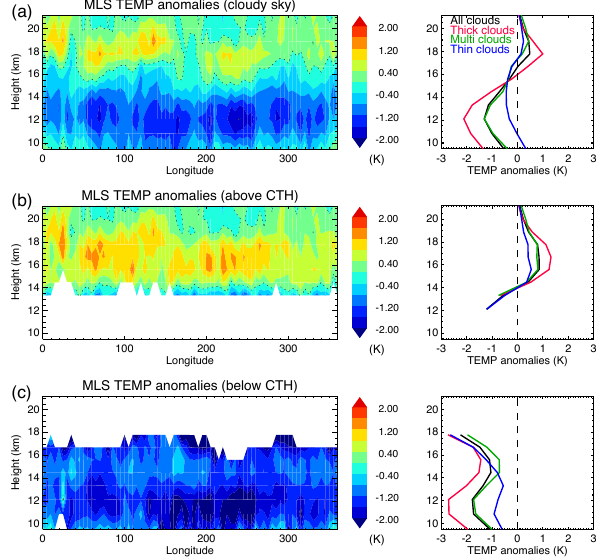
Fig. 3. Time mean vertical profiles of temperature anomaly from the local, clear-sky mean temperature for cloud tops above 10 km (a). (b) the same as (a) except that only data at least 1.5 km higher than the cloud top height (CTH) are included in the average. (c) the same as (a) except data height is below cloud top but not by more than 3 km. Right figures show zonally averaged anomalies of absolute value.